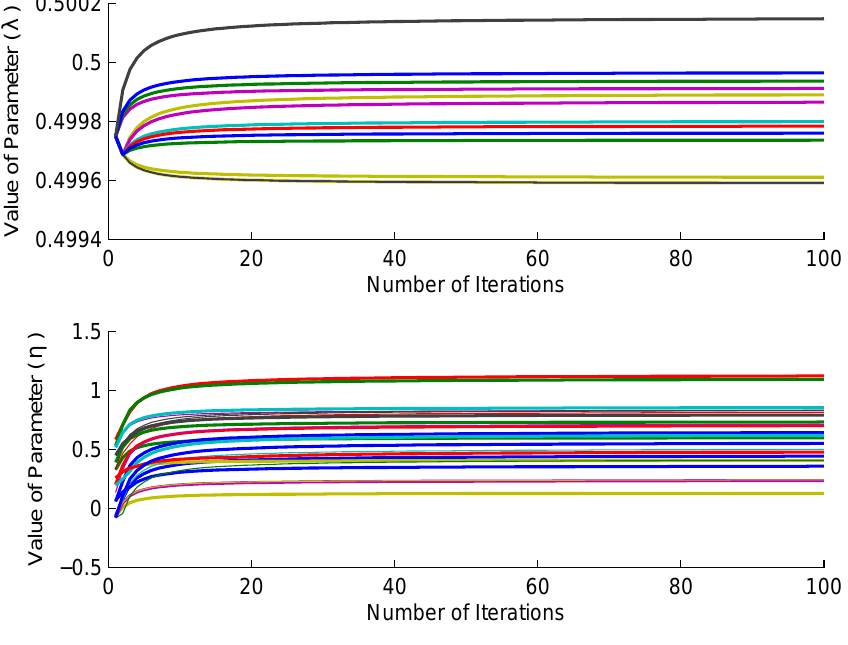
Figure 9. Convergence versus No of